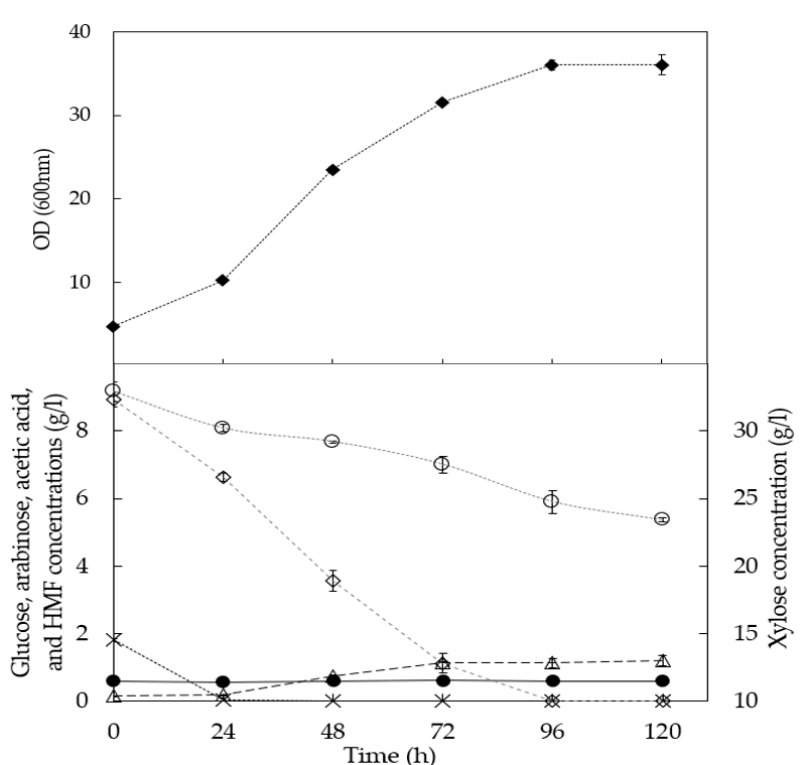
Figure 4. Kinectics of R. toruloides growth and carbon source consumption. Cultivation time 120 h. Symbols: xylose (o), glucose ( × ), acetic acid ( ♦ ), arabinose ( • ), and HMF ( ∆ ) concentrations; OD at Symbols: xylose (o), glucose (×), acetic acid ( ◊ ), arabinose ( ● ), and HMF ( ∆ ) concentrations; OD at 600 600 nm. Lines are a guide to the nm. Lines are a guide to the eye.